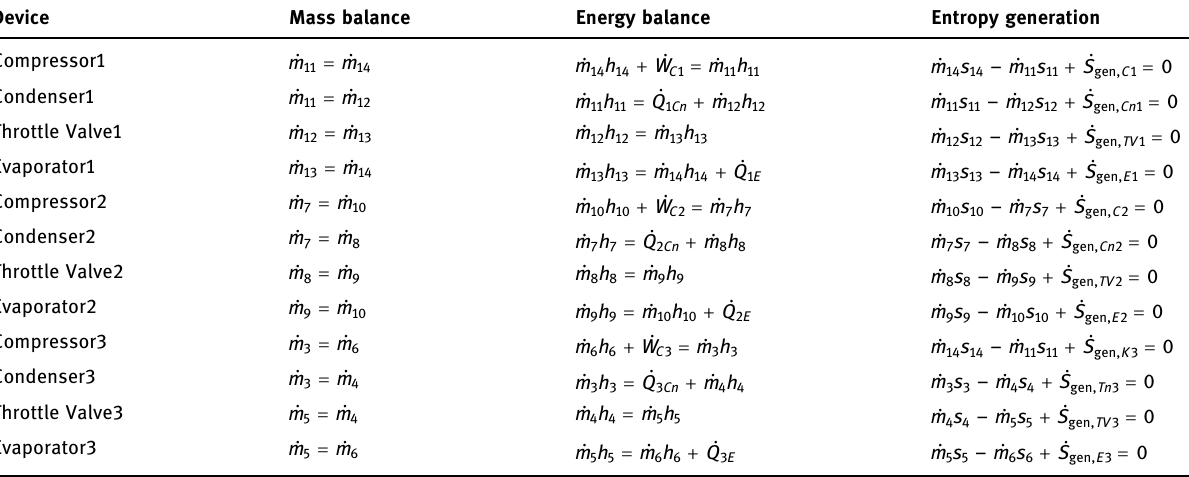
Table 4: Formulas for the mass and energy balance and entropy generation of the devices of the three - stage vapor compression cascade cryogenic cycle [ 2,4 – 6 ]